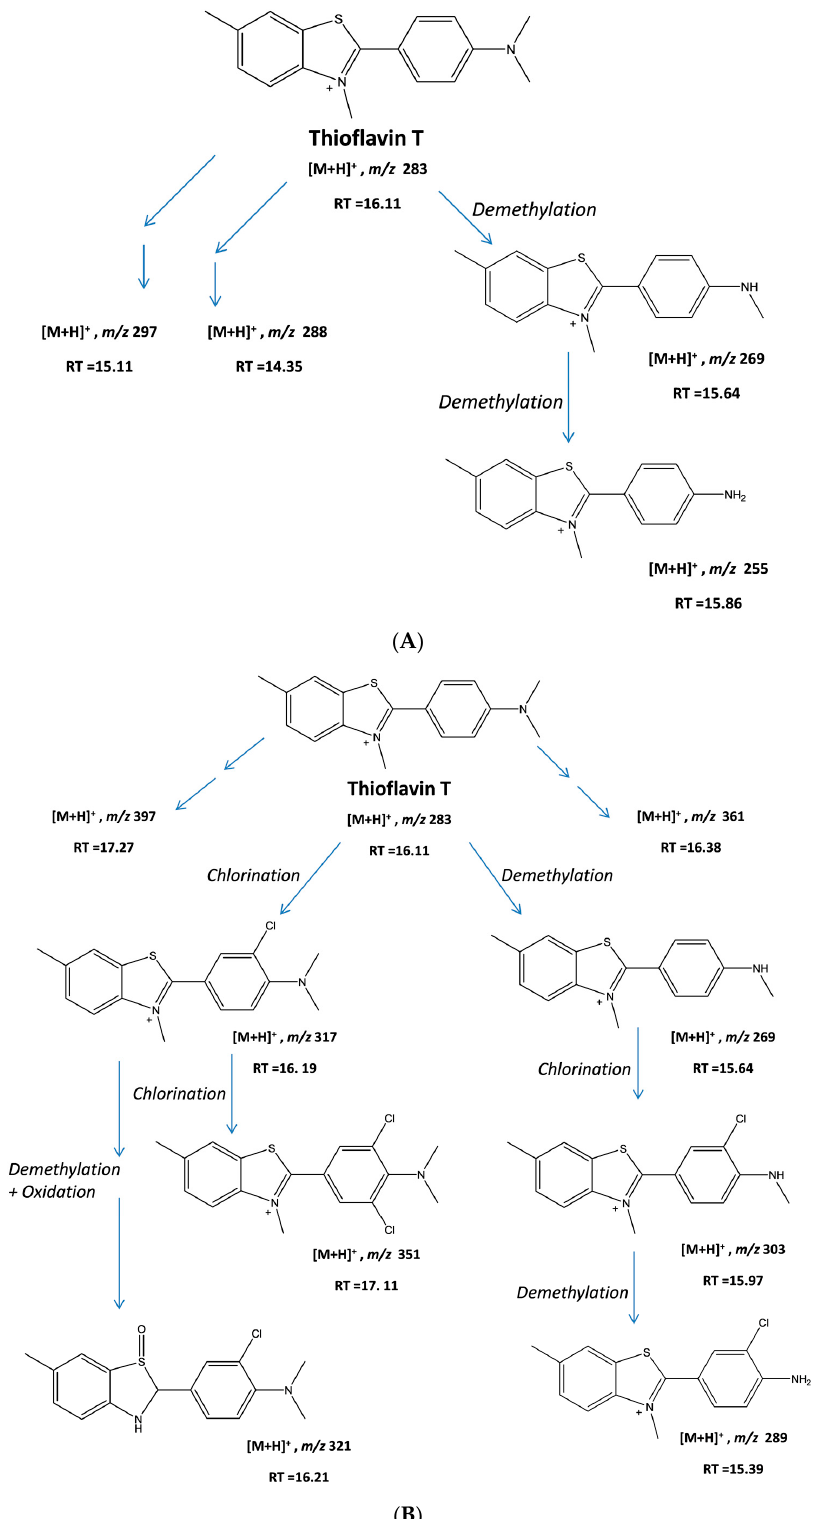
Figure 6. ( A ) Proposed structures of some of the intermediates generated during the UV + H 2 O 2 -based degradation of ThT dye; ( B ) Proposed structures of some of the intermediates generated during the CPO + H 2 O 2 -based degradation of ThT dye. RT: retention